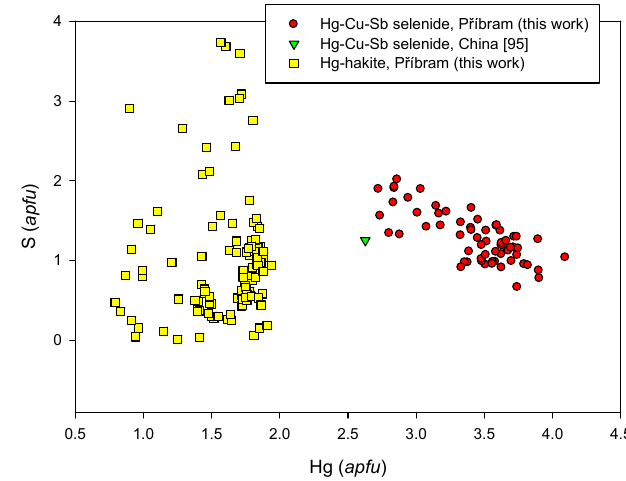
Figure 69. Hg vs. S ( apfu ) graph for unnamed Hg-Cu-Sb selenide and Hg-hakite.